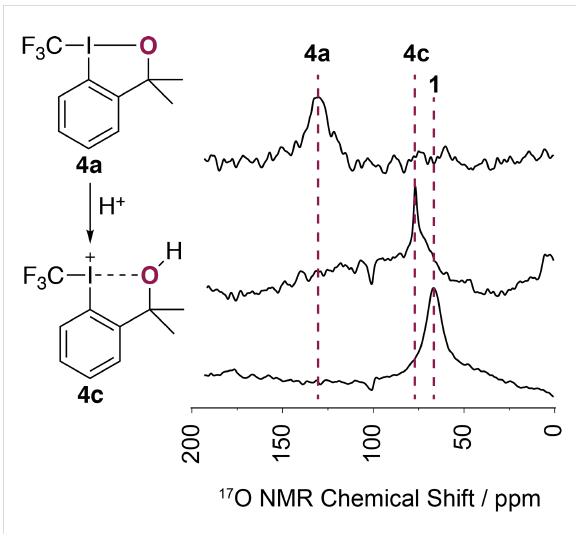
Figure 3: Protonation of 4a with trifluoroacetic acid (5 equiv) affords 4c , followed by 17 O NMR